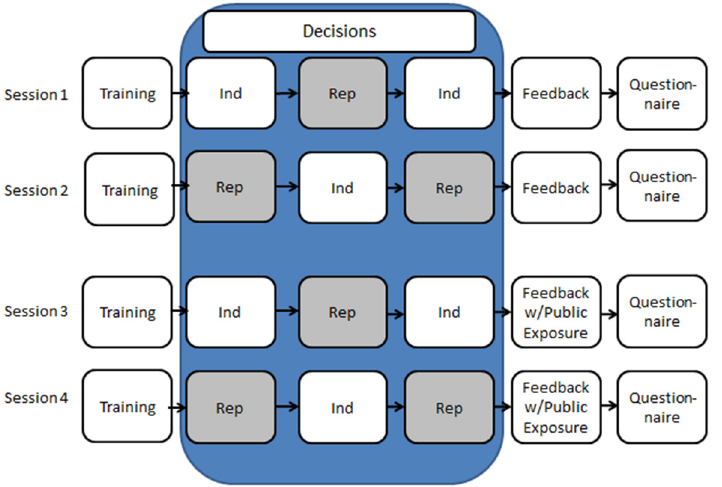
Figure 1. Outline of the experimental design. Decisions as Individuals (Ind) and Decisions as Group Representatives (Rep).